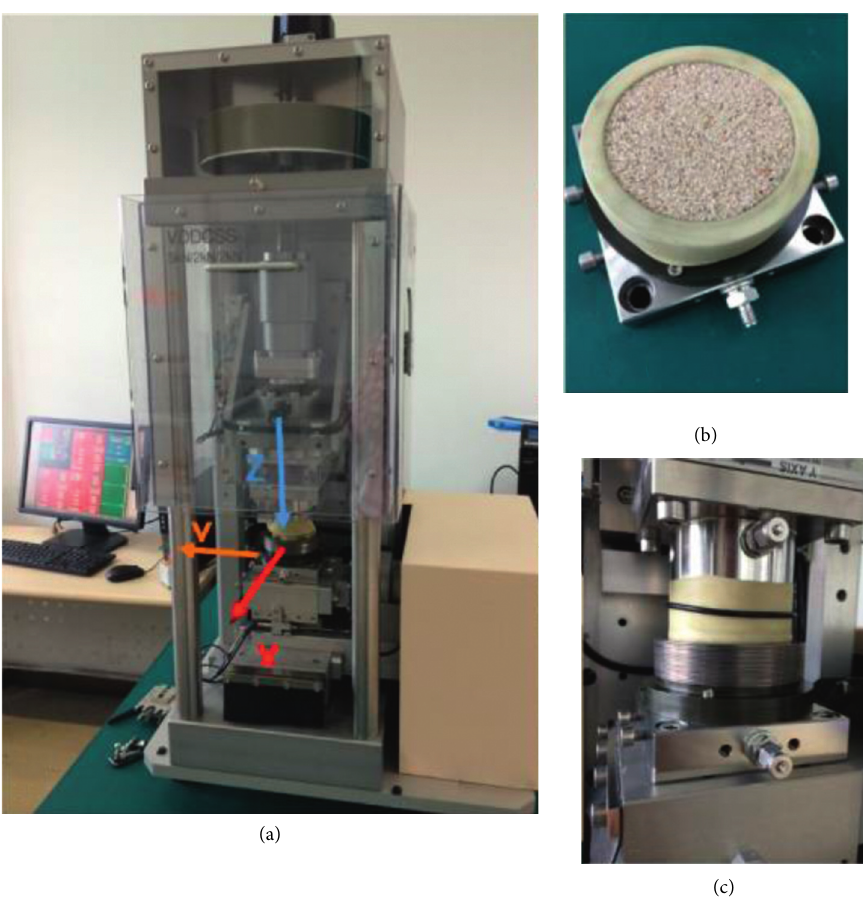
Figure 1: The VDDCSS: (a) the apparatus and loading directions; (b) a prepared sand specimen; (c) a specimen after consolidation [11].